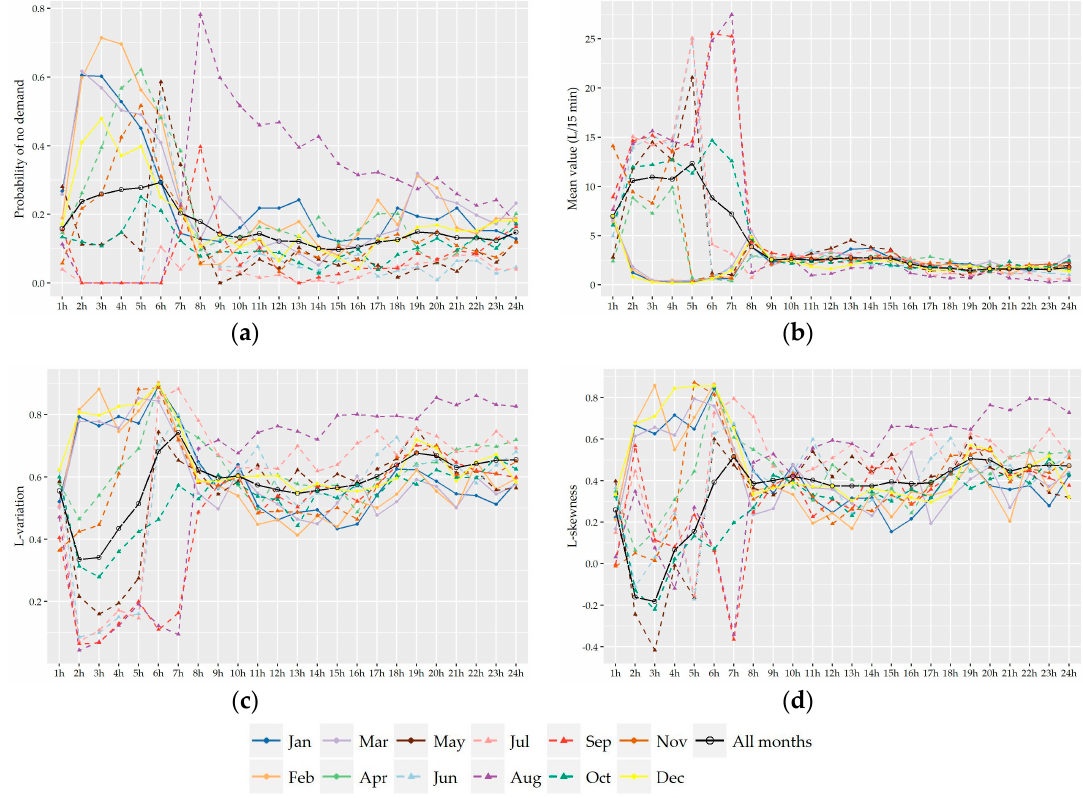
Figure A4. 15-min scale : Daily variation of the probability of no demand ( a ), mean value ( b ), L-variation ( c ), and L-skewness ( d ) of the 15-min nonzero demand records of House #1 for each month.